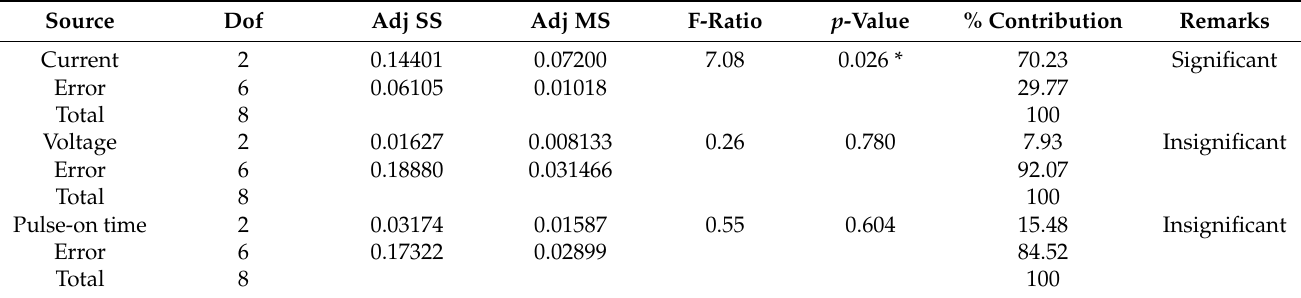
Table 12. ANOVA for Source vs. MRR.